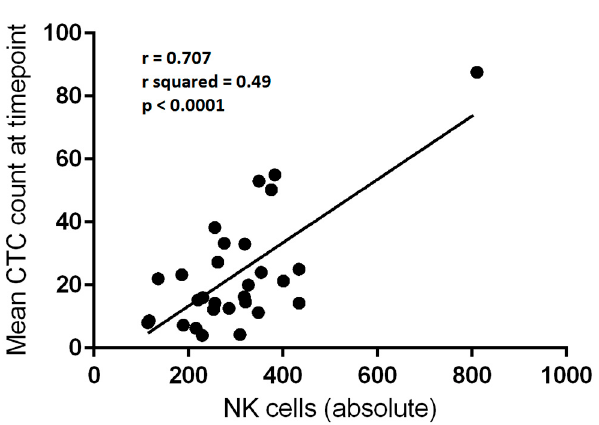
Figure 2. Correlation between absolute natural killer (NK-cell) count (per µ L) and mean circulating tumour cell (CTC) count per 3 mL of blood at a given blood draw ( n = 29). Linear regression, r = 0.707; r 2 = 0.49; p < 0.0001.